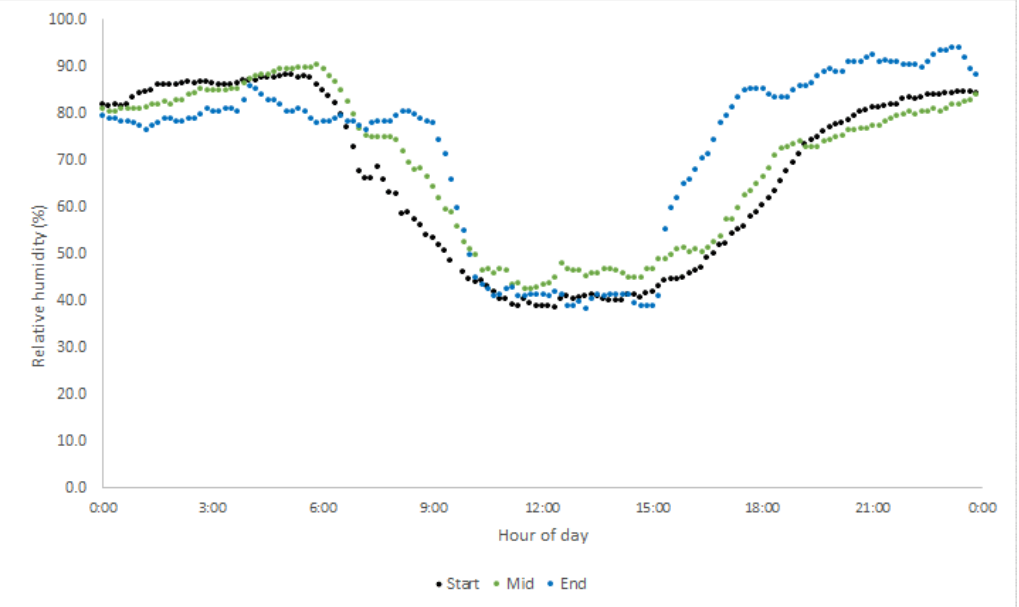
Figure A2. Mean temperature records, collected at 10-min intervals, for the dates on which flowering progression was monitored in 2018. The sun and moon symbols indicate the times of sunrise and sunset on the monitoring days.